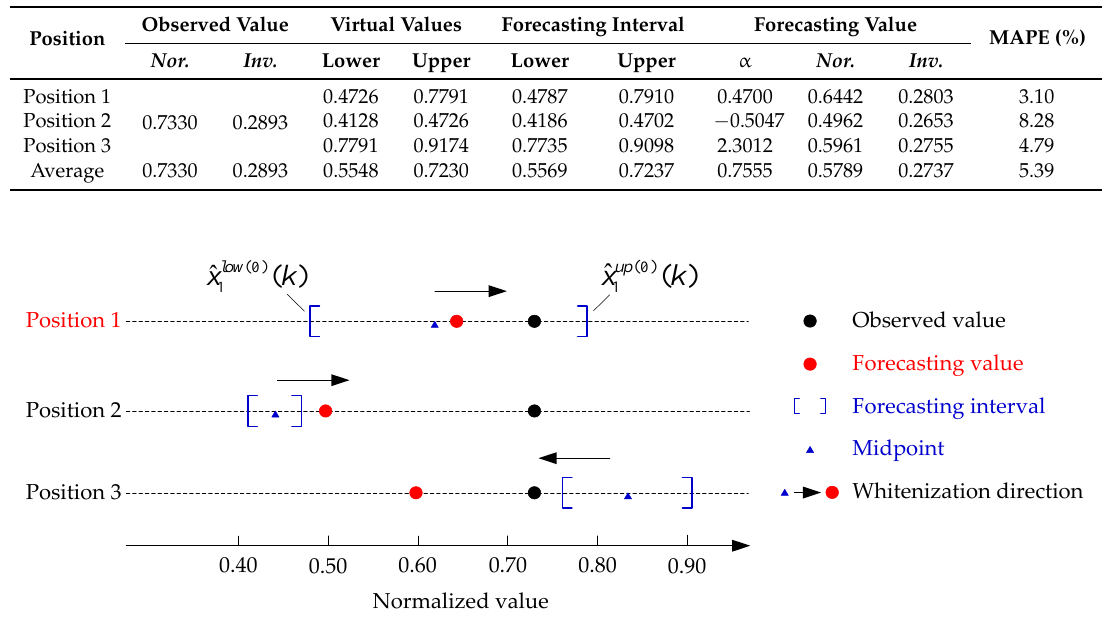
Figure 9. Definite forecasting values of Positions 1–3 determined by the novel whitenization method.